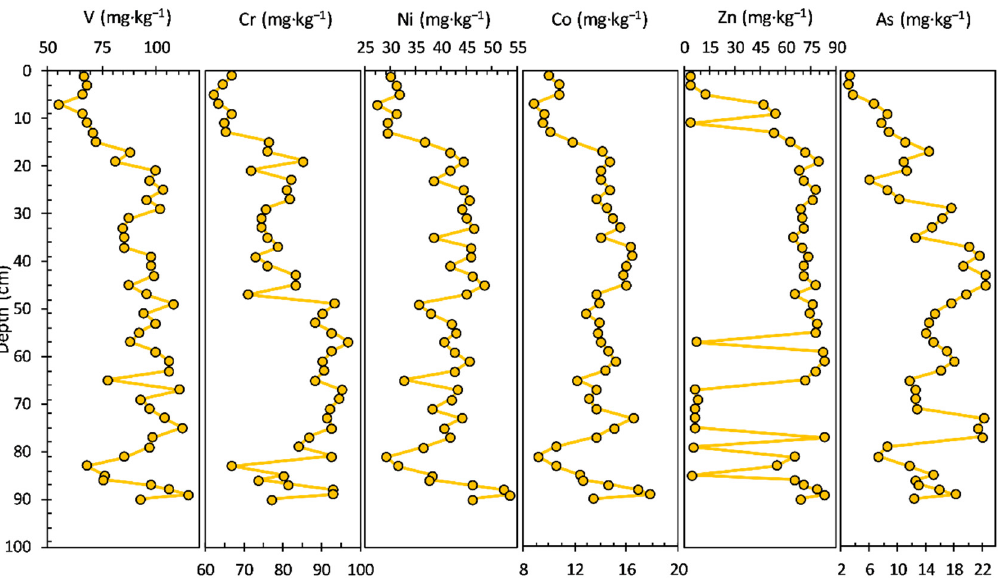
Figure 11. Vertical distribution of geochemical heavy metals (V, Cr, Ni, Co, Zn, As) in the Movila Miresii Lake sediment core (90 cm depth). Miresii Lake sediment core (90 cm